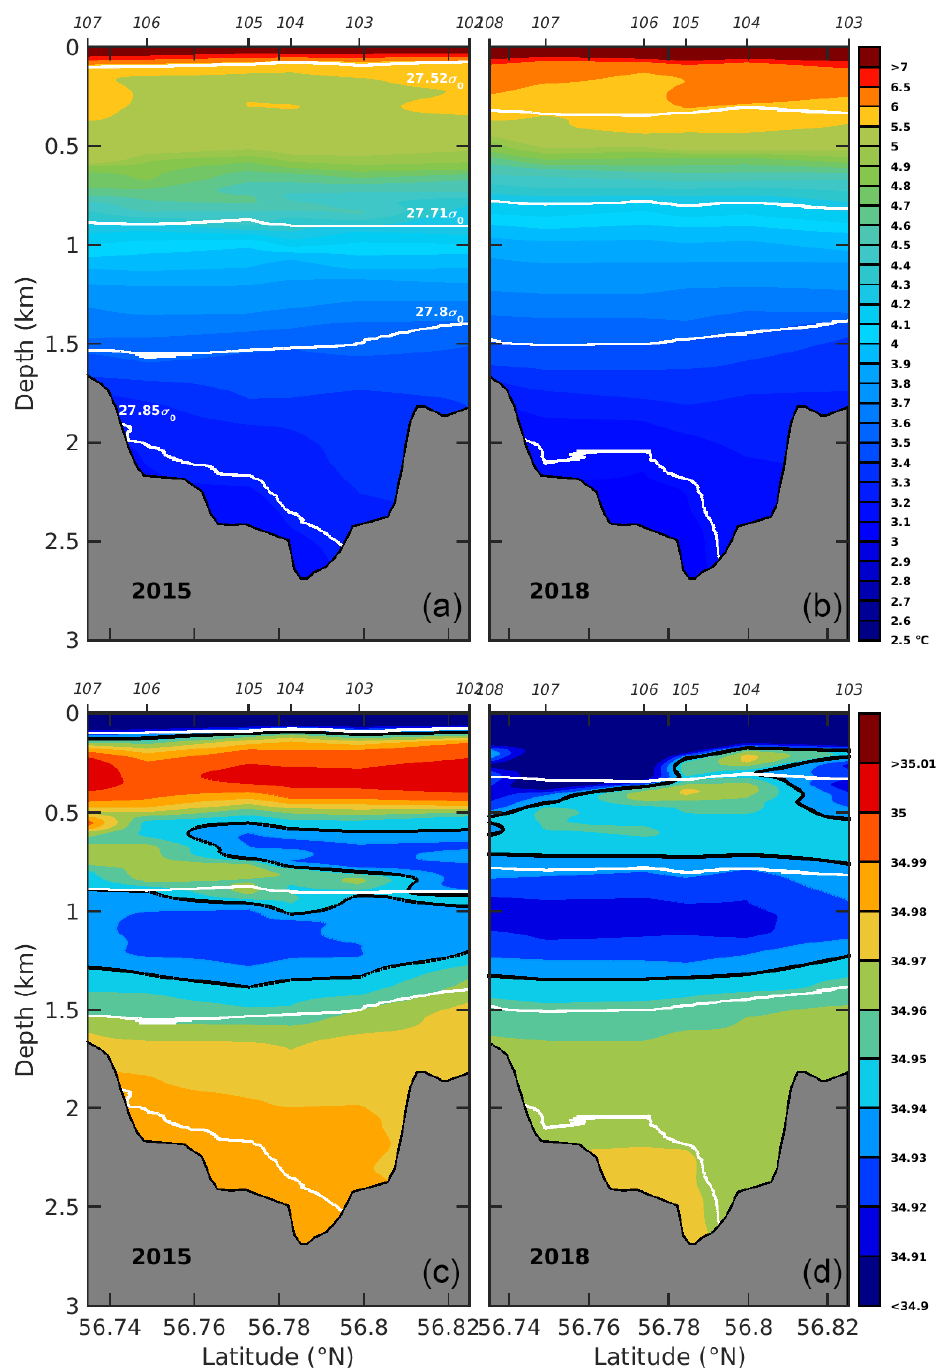
Figure A2. Hydrographic sections along the Middle sections in 2015 and 2018 based on CTDO2 data for (a, b) potential temperature in degrees Celsius and (c, d) salinity. The bold black lines represent isohaline 34.94 for the lower panels. In all panels, the bold white lines show the potential density anomalies σ 0 = 27 . 52, 27.71, 27.8 and 27.85kgm − 3 . Bathymetry in gray is from the ship surveys. Locations of the hydrographic stations are indicated on the top